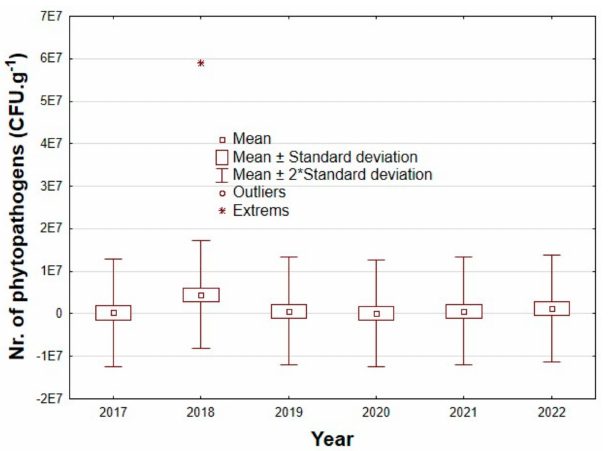
Figure 5. The average number of occurrences of phytopathogens in individual years and at individual sampling sites.